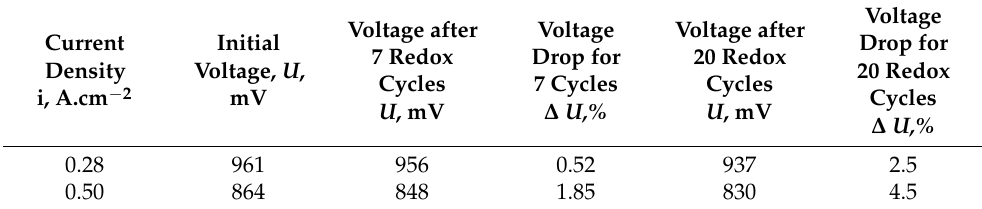
Table 1. Voltage decrease at constant current density extracted from the i -V curves measured during redox cycling.